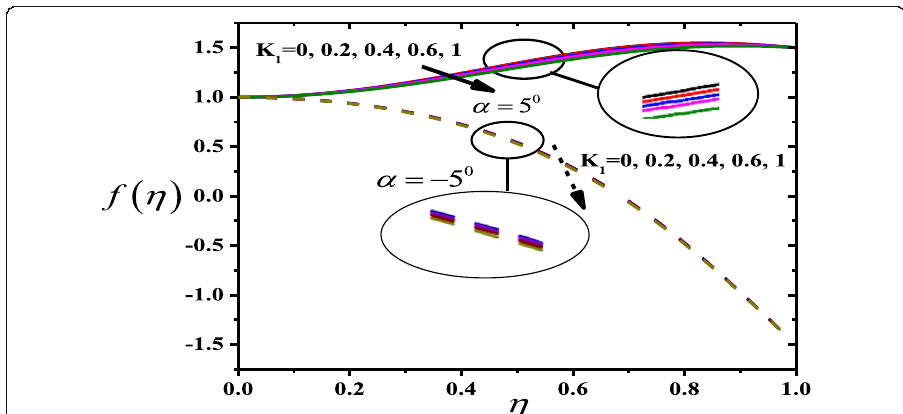
Fig. 6 Velocity vs. K 1 in stretching divergent and shrinking convergent channels